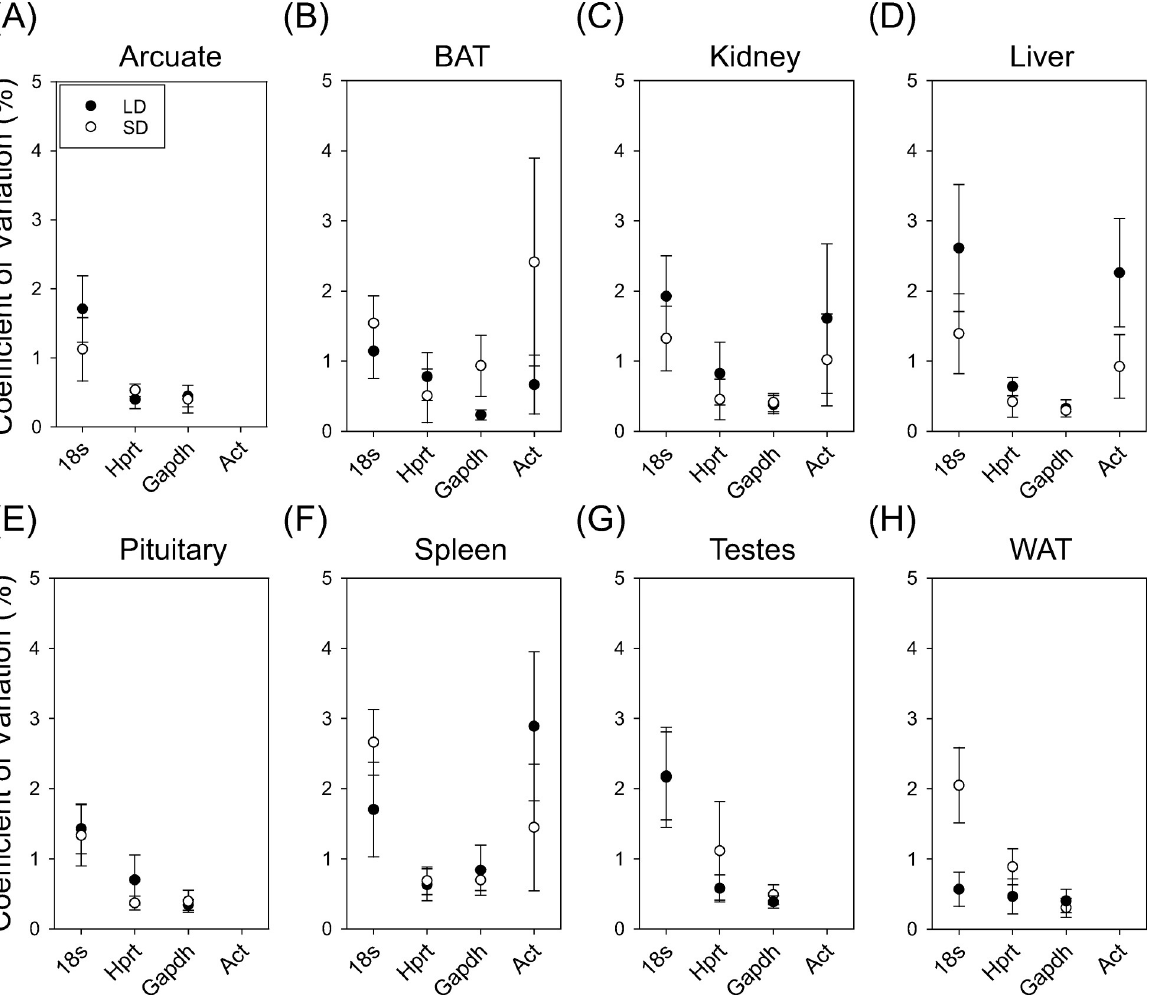
Fig 2. Coefficient of variation of Ct of 18s, Hprt, Gapdh and Act in hamster tissues across photoperiod conditions. Mean coefficient of variation (CV%) of 18s, Hprt, Gapdh and Act in arcuate (A), BAT (B), kidney (C), liver (D), pituitary (E), spleen (F), testes (G) and Wat (H).